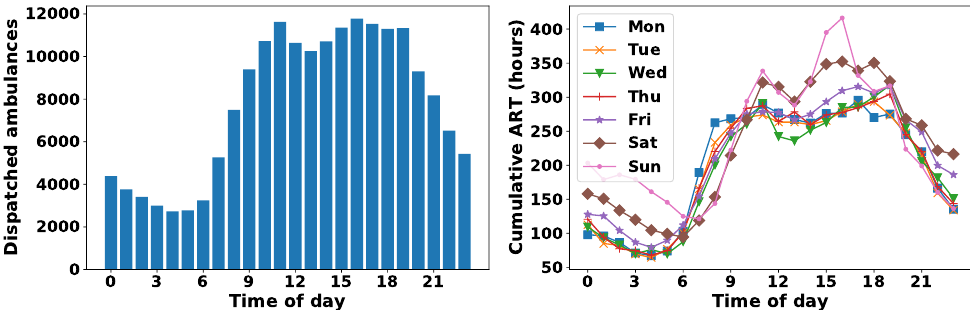
Figure 2. Histogram of the total number of dispatched ambulances per hour in the day ( left-hand plot ) and cumulative ART in hours per day of the week and hour in the day ( right-hand plot